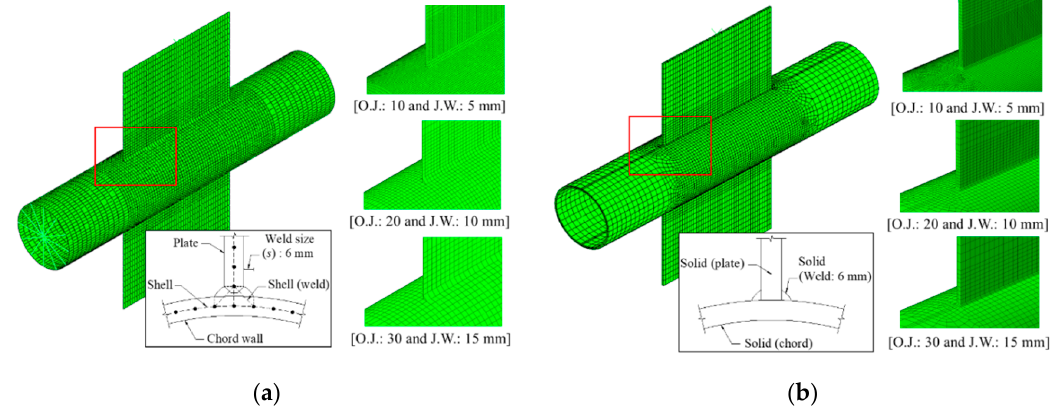
Figure 3. Mesh composition of the shell and solid element (LH-N700-0.0): ( a ) shell; ( b ) solid element.